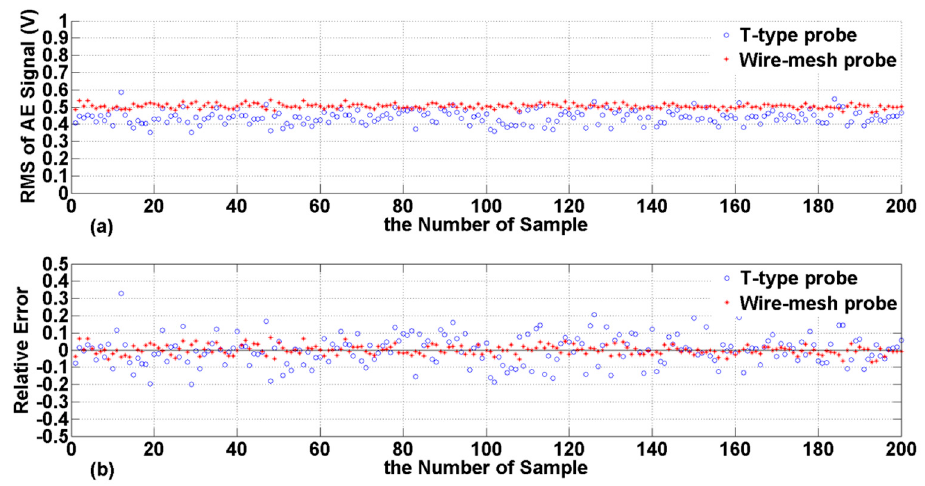
Figure 7. ( a ) The root mean square (RMS) distribution and ( b ) the relative error for each probe type.